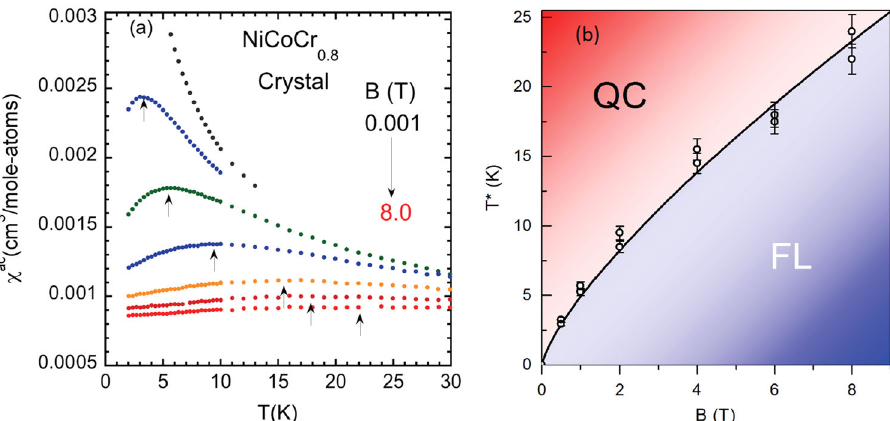
Fig. 6 Field induced crossover from quantum critical to Fermi liquid regimes a ac susceptibility vs. temperature with applied dc magnetic fi elds between 0.001 and 8 Tesla. The black arrows denote the approximate values of T * for a fi xed dc magnetic fi eld. b The crossover temperature, T *, as a function of magnetic fi eld for a NiCoCr 0.8 single crystal as determined from both DC magnetization and ac susceptibility data. The error in T * re fl ects the uncertainty in determining the temperature of the maximum using either ac or dc susceptibility data. The regions dominated by quantum critical (QC) and Fermi liquid (FL) behavior are noted in the fi gure. The black line is a power law fi t to the data: T * = 5.62 B 0.67 ± 0.05 where the error bars are the standard deviation from least squares fi